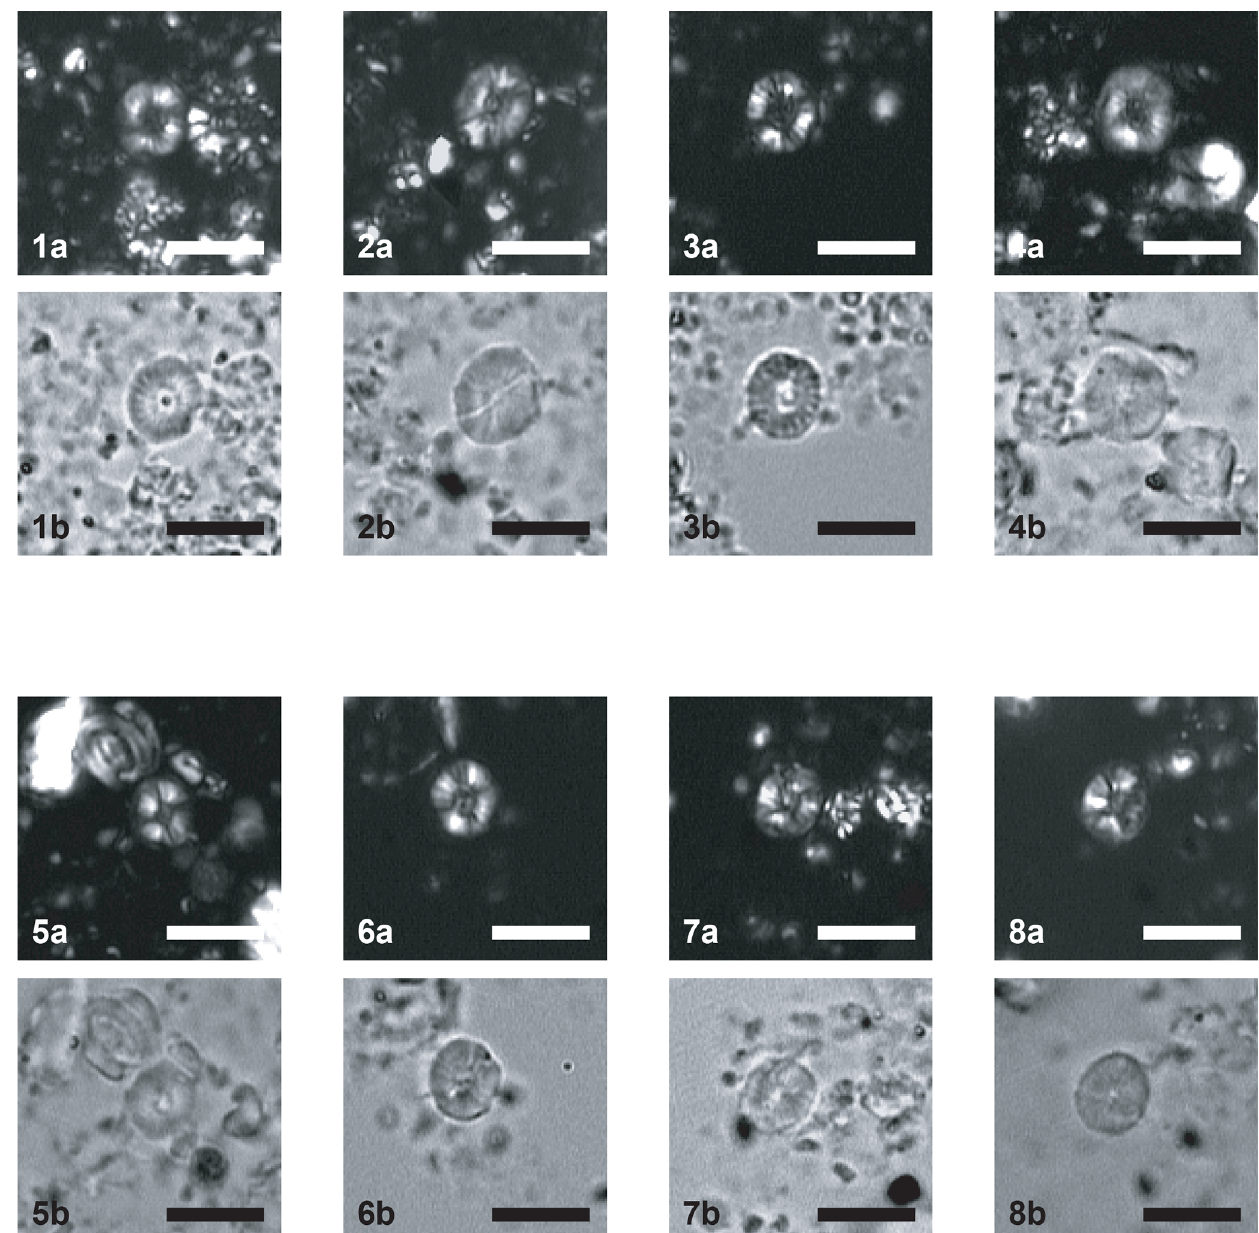
Plate 2. Scale bar = 5µm. CPs indicates crossed polars; PPs indicates parallel polars. (1–4) Similiscutum finchii . (1a) CPs and (1b) PPs, sample PEN08-Do2003 (Emaciatum Zone). (2a) CPs and (2b) PPs, sample PEN08-Do2003 (Emaciatum Zone). (3a) CPs and (3b) PPs, sample PEN08-Do2003 (Emaciatum Zone). (4a) CPs and (4b) PPs, sample PEN25bis-To2003 (Polymorphum Zone). (5–8) Similiscutum novum . (5a) CPs and (5b) PPs, sample PEN25bis-To2003 (Polymorphum Zone). (6a) CPs and (6b) PPs, sample PEN25bis-To2003 (Poly- morphum Zone). (7a) CPs and (7b) PPs, sample PEN25bis-To2003 (Polymorphum Zone). (8a) CPs and (8b) PPs, sample PEN25bis-To2003 (Polymorphum